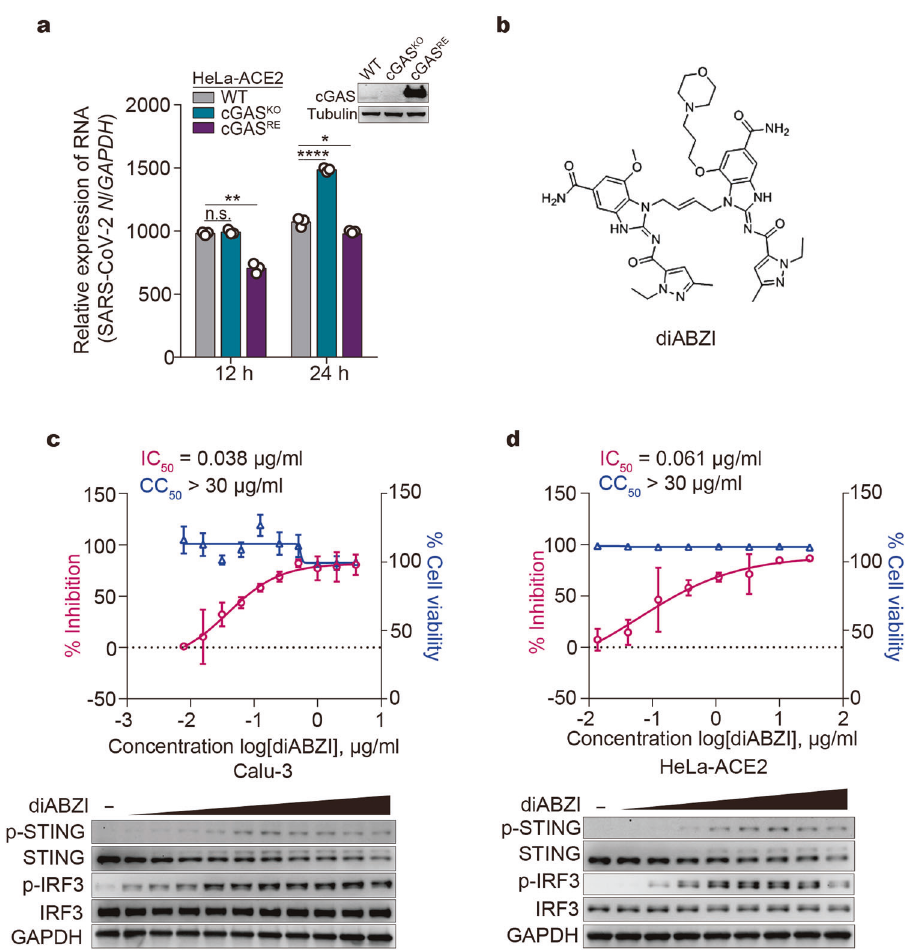
Fig. 6 Targeting cGAS-STING pathway as potential therapeutics against SARS-CoV-2. a Effect of cGAS expression on SARS-CoV-2 replication. Wildtype HeLa-ACE2 (WT), HeLa-cGAS KO -ACE2, and HeLa-cGAS RE -ACE2 cells were infected with SARS-CoV-2 at an MOI of 0.5. At indicated times, total RNA extracted from cells was evaluated by quantitative PCR. The data are expressed as fold changes of the RNA levels of the viral N gene relative to the GAPDH control. Mean ± s.d., n = 3. * P < 0.05, ** P < 0.01, **** P < 0.0001, n.s. not signi fi cant. Two-tailed Student ’ s t -test. b The chemical structure of diABZI. c , d Antiviral effect of diABZI on SARS-CoV-2. Calu-3 ( c ) or HeLa-ACE2 ( d ) cells were treated with serially diluted diABZI for 24 h (Calu-3) or 1 h (HeLa-ACE2). Cells were then subjected to viability assay or infected with SARS-CoV-2 at an MOI of 0.2. After 24 h (Calu-3) or 48 h (HeLa-ACE2), supernatants were harvested for RNA extraction, followed by absolute quanti fi cation of viral N mRNA by PCR. Mean ± s.d., n = 4. The IC 50 (the half-maximal inhibitory concentration) and CC 50 (the half-maximal cytotoxic concentration) values were calculated using Prism software. Lower panels showed diABZI-induced STING and IRF3 activation. Calu-3 ( c ) or HeLa-ACE2 ( d ) cells were treated with serially diluted diABZI for 24 h and 6 h, respectively, followed by Western blot analysis using indicated